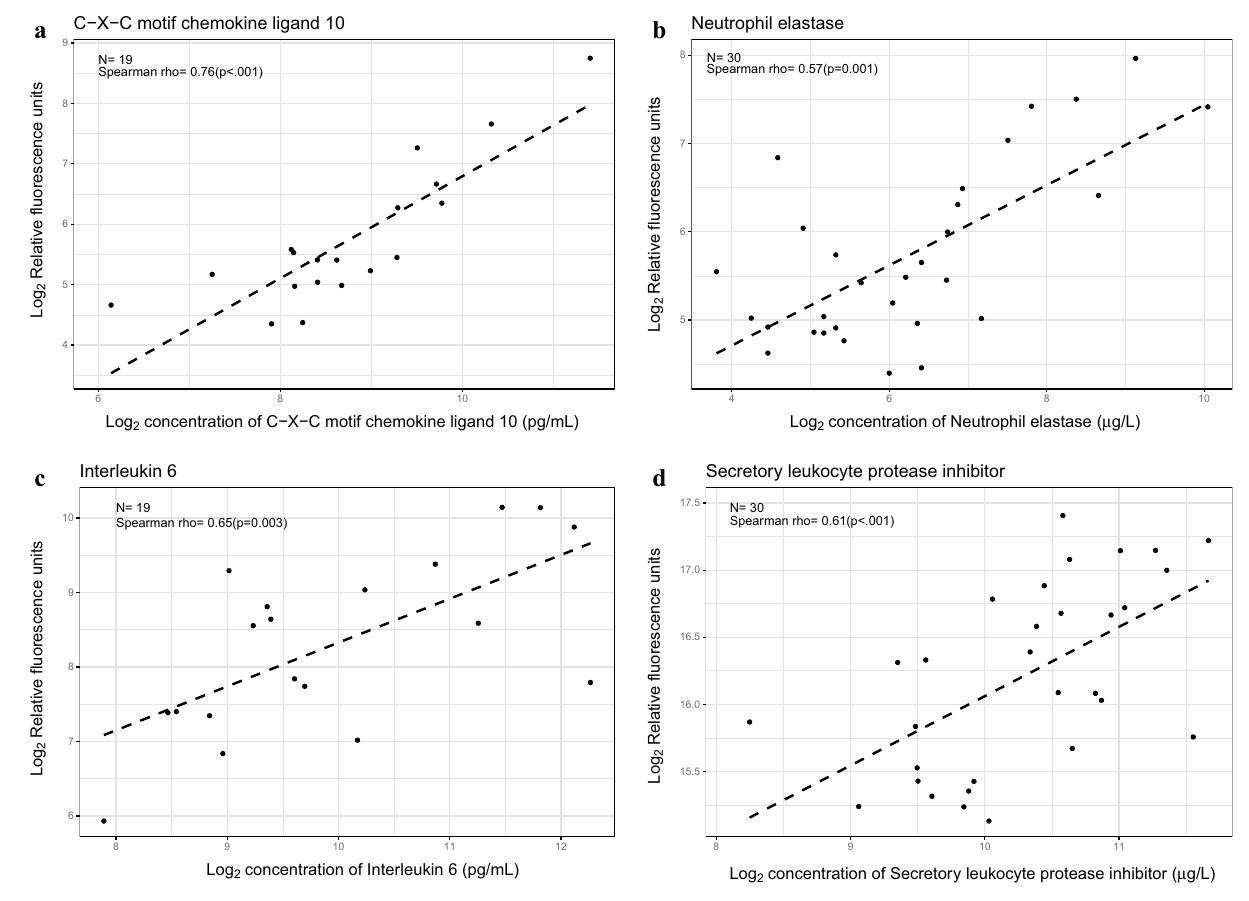
Figure 2. Cross-platform correlation of specific amniotic fluid proteins. Scatter plots of log 2 -transformed relative fluorescence units determined by using the SOMAscan assay (y-axis) and log 2 -transformed ELISA or RIA concentrations (x-axis) for ( a ) C–X–C motif chemokine ligand 10 (CXCL10), ( b ) neutrophil elastase (ELANE), ( c ) interleukin (IL)-6, and ( d ) secretory leukocyte protease inhibitor (SLPI). The number of sample pairs, Spearman’s correlation coefficient, and the corresponding p-value are shown per analyte. The scatter plots were generated with the R package, ggplot2 159